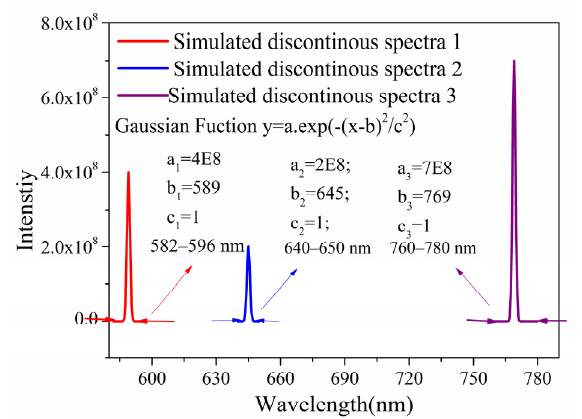
Figure 2. Simulated discontinuous spectral bands.